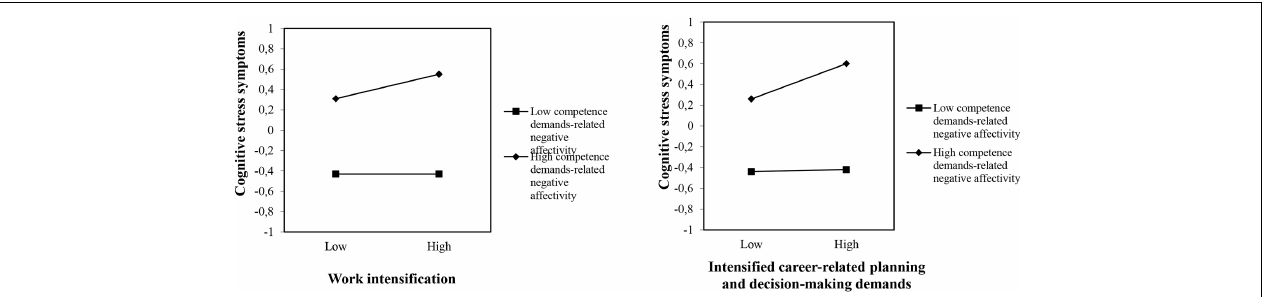
FIGURE 1 | Competence demands-related negative affectivity as a moderator in the association between work intensification/intensified career-related planning and decision-making demands and cognitive stress symptoms. The scale on the Y -axis as well as the entries “low” and “high” refer to –1 and +1 standard deviation below and above the sample mean in the variable in